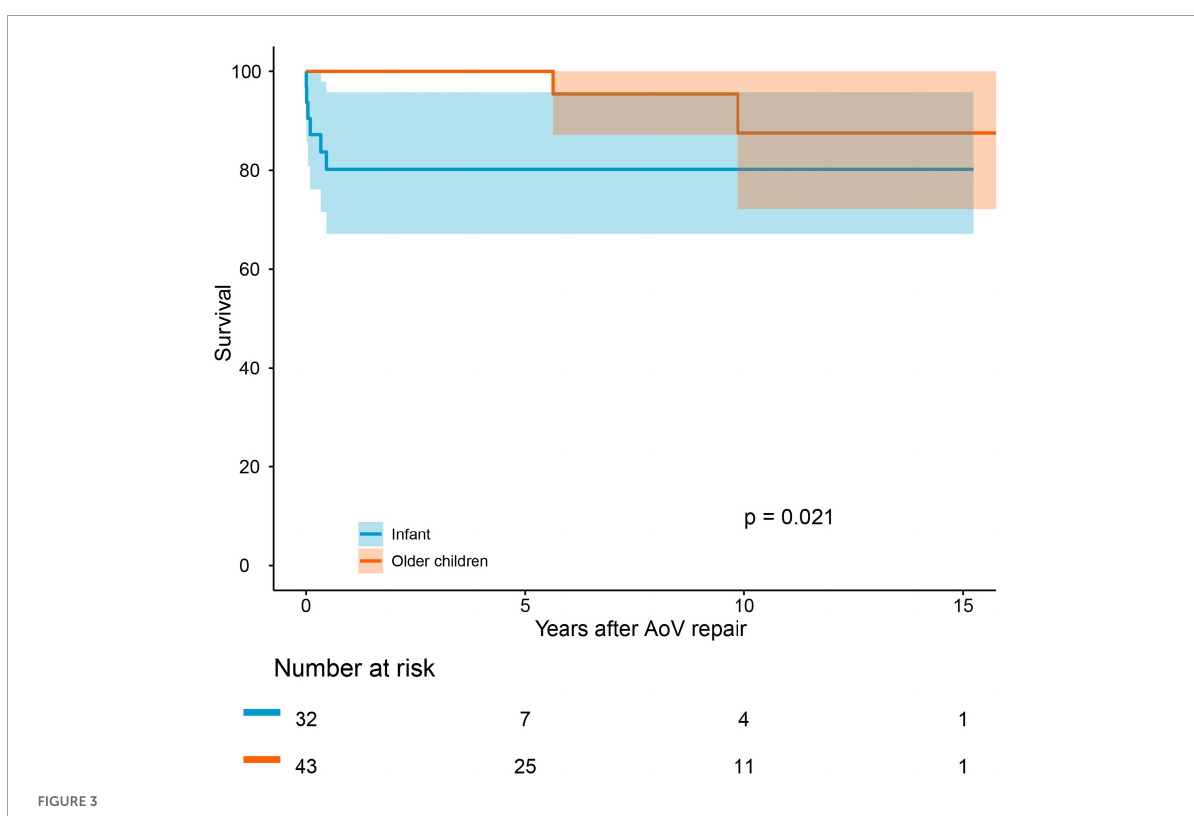
FIGURE3 Survival comparing of infants and children older than 1 year of age.